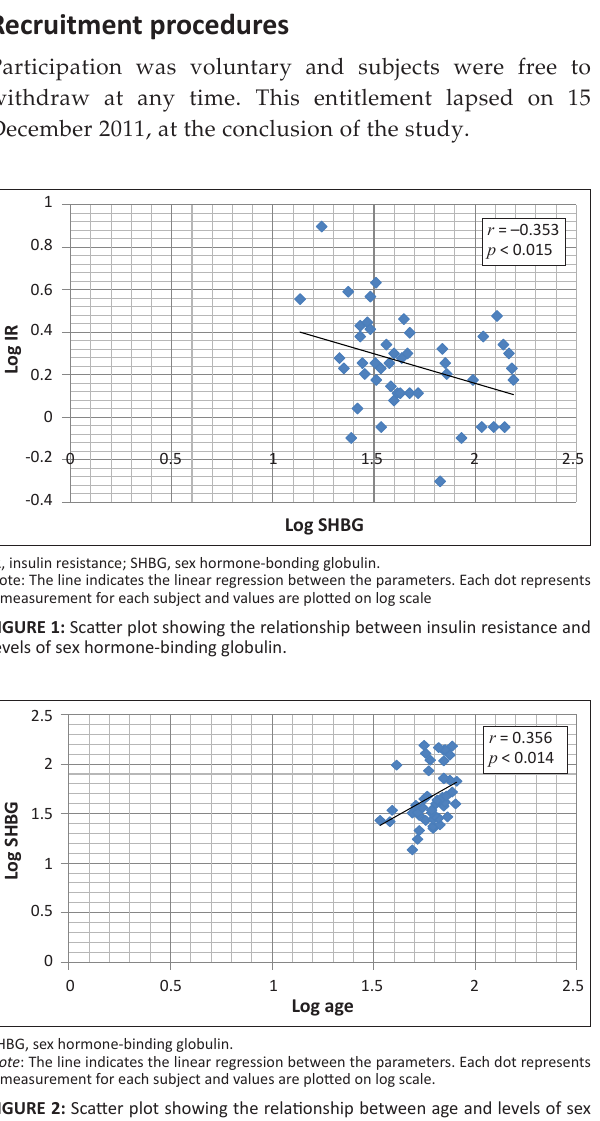
FIGURE 2: Scatter plot showing the relationship between age and levels of sex hormone-binding